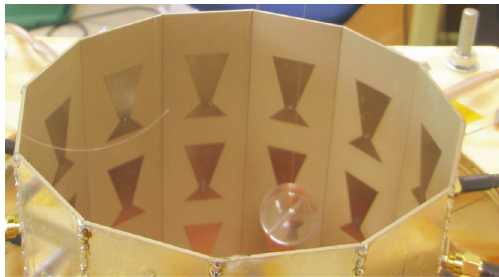
Figure 22: Second cavity with antennas designed to operate at 915 MHz of Experiment 2. Three acrylic sphere are suspended (one visible). Cavity is filled with fluid for